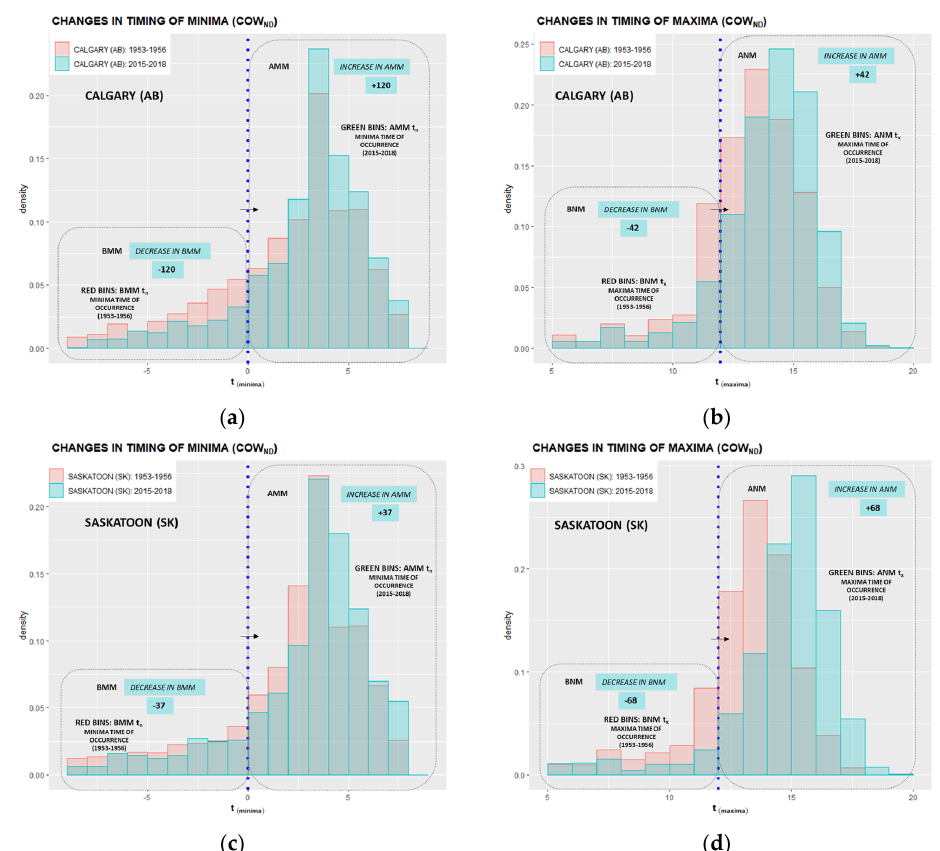
Figure A15. Prairies climate region: Calgary (AB) and Saskatoon (SK). Time evolution of the Diurnal Extrema Timing (DET) histograms at Calgary ( a , b ), and Saskatoon ( c , d ) stations. Migration of the Before Midnight Minima (BMM) to After Midnight Minima (AMM) and migration of the Before Noon Maxima (BNM) to After Noon Maxima (ANM) between four-year averages at the beginning (1953– 1956) and ending (2015–2018) of data ranges. The blue dotted line represents midnight delineation ( left ) and noon delineation ( right